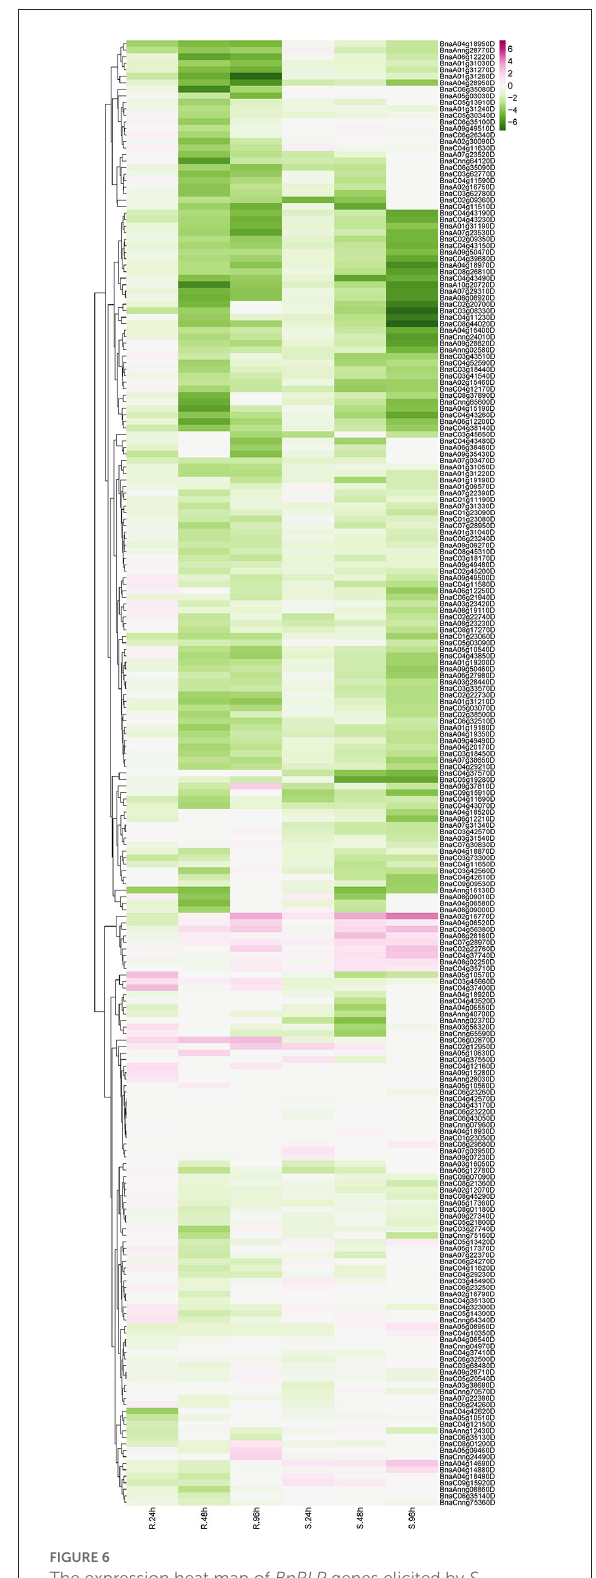
FIGURE6 The expression heat map of BnRLP genes elicited by S. sclerotiorum. The expression heat map of BnRLP genes in